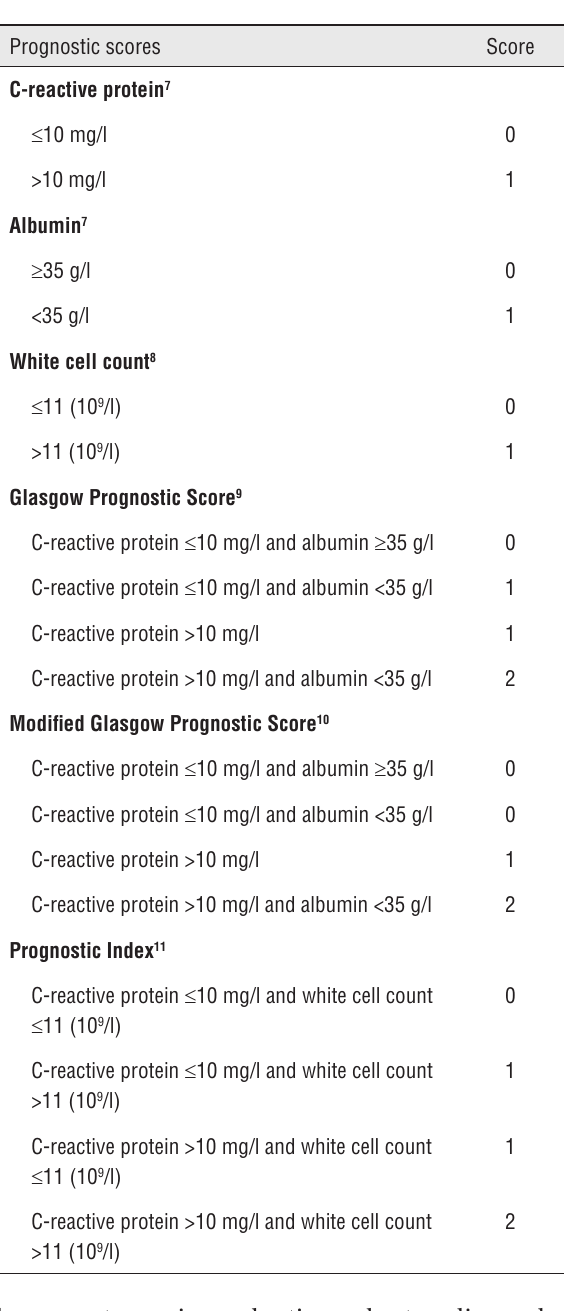
Table 2 - Systemic inflammation-based prognostic